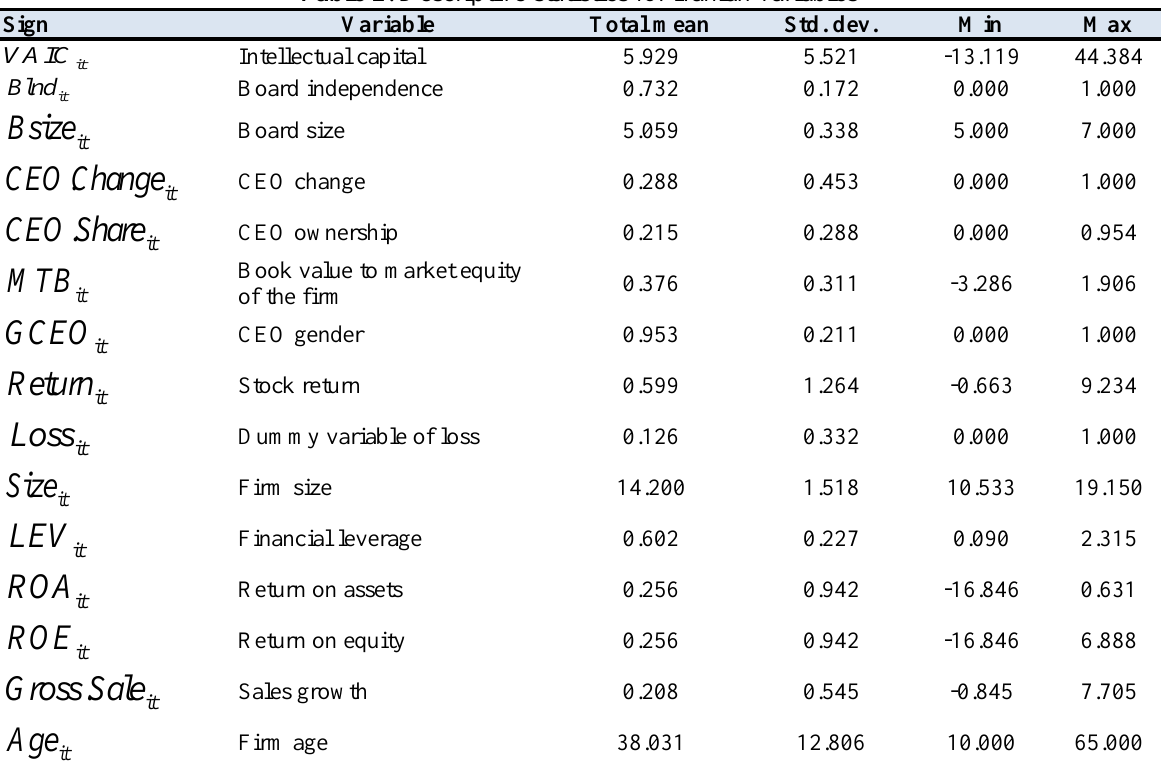
Table 2 . Descriptive statistics for Iranian variables